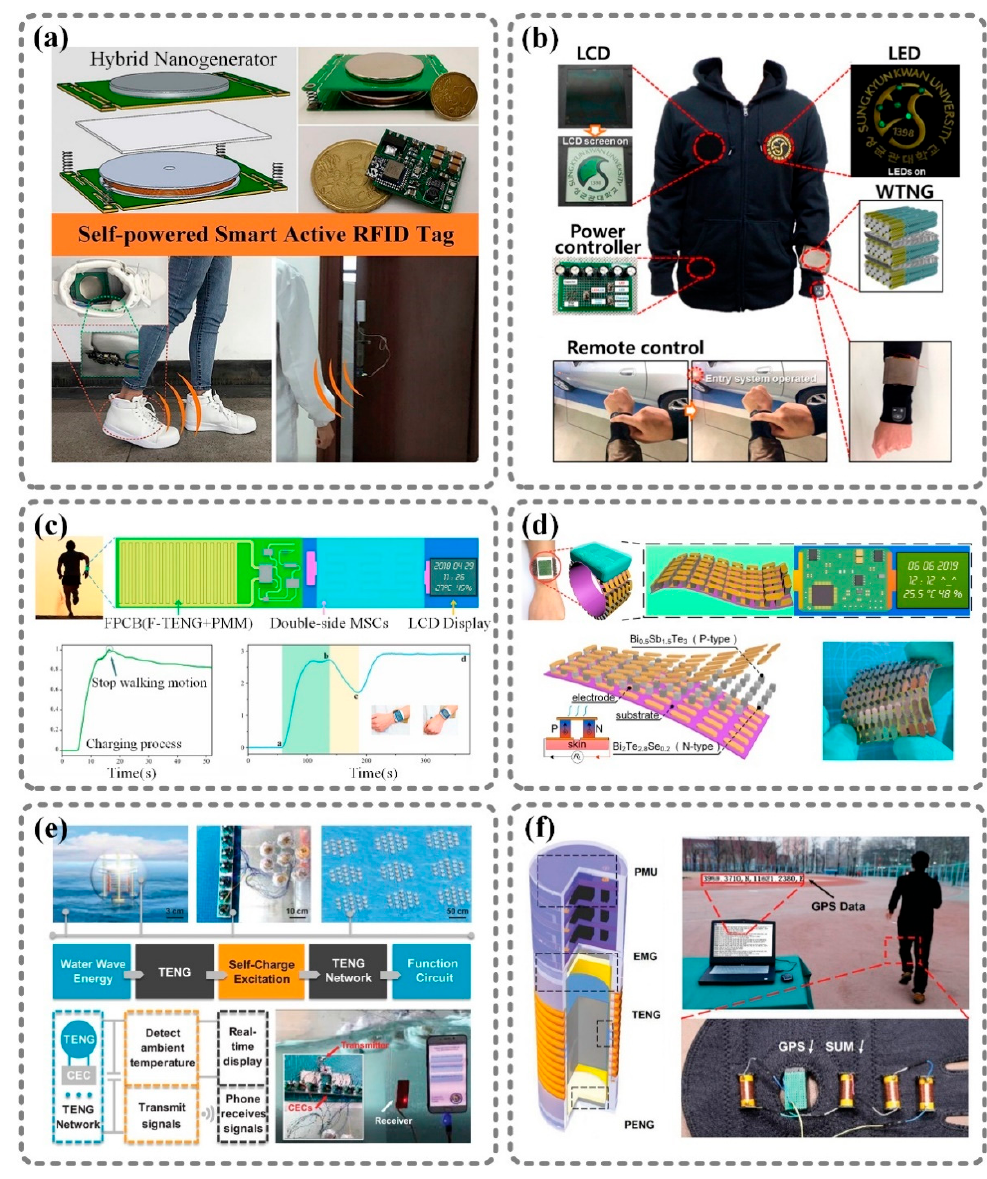
Figure 5. Self-powered systems with power management modules using nanoenergy. ( a ) Triboelectric-electromagnetic hybrid nanogenerator: self-powered RFID tag integrated with a hybrid nanogenerator [31]. ( b ) Nanopatterned textile-based wearable triboelectric nanogenerator: self-powered smart suit based on a textile-based wearable TENG [70]. ( c ) FPCB integrated with TENG, PMM, MSC and functional circuit: self-powered smart bracelet based on a freestanding-mode TENG [71]. ( d ) Thermoelectric grains bonding on flexible polyimide substrate: self-powered wearable monitoring system with a flexible thermoelectric generator (TEG) [72]. ( e ) TENG network with spring-assisted multilayered structure: water wave energy harvesting system that can power electronic thermometer and RF transmitter [73]. ( f ) Battery-like self-charging universal module for motional energy harvest: universal self-charging module composed of a “three-in-one” hybrid nanogenerator (electromagnetic generator (EMG), TENG, and piezoelectric nanogenerator (PENG)) and power management unit, which can support a GPS system. [74]. Reproduced with permission from John Wiley and Sons [73,74], Elsevier [31,71,72], and American Chemical Society